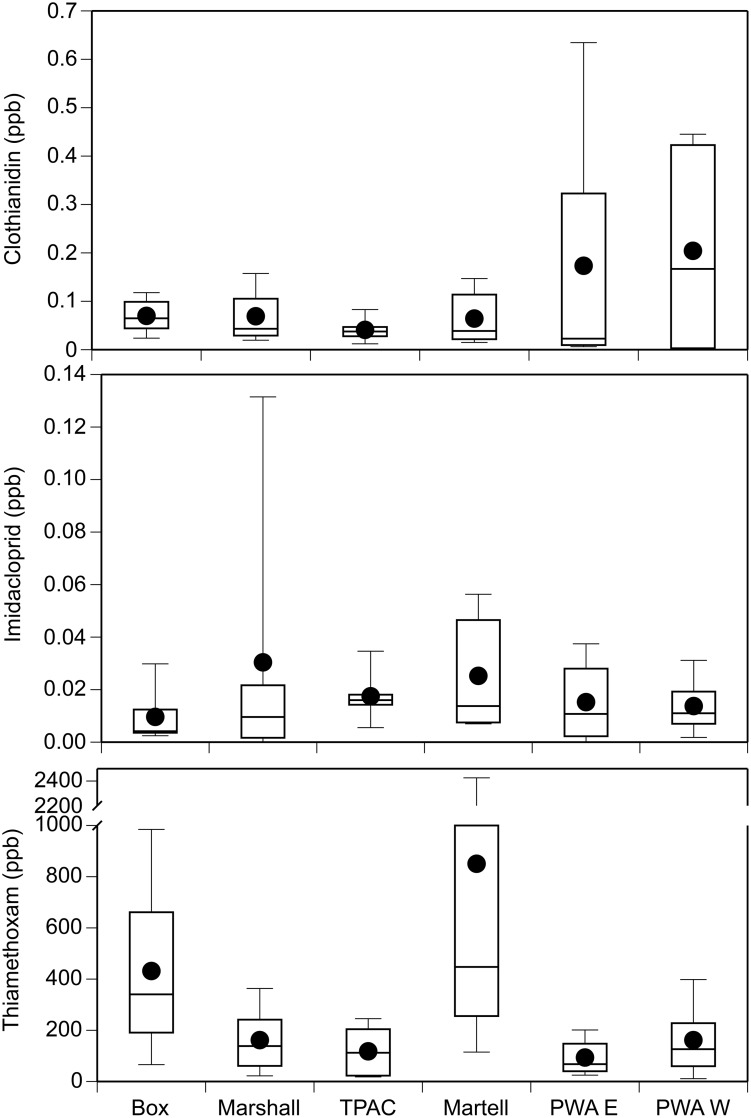
Boxplots of clothianidin, imidacloprid, and thiamethoxam concentrations (ppb) detected in water samples at six sites in Tippecanoe County, Indiana.Data includes samples taken throughout the growing season.